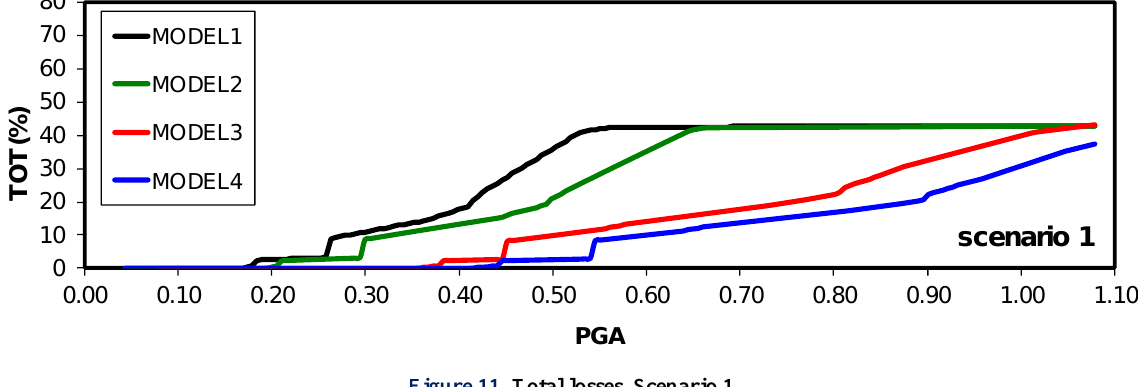
Figure 11. Total losses. Scenario 1.